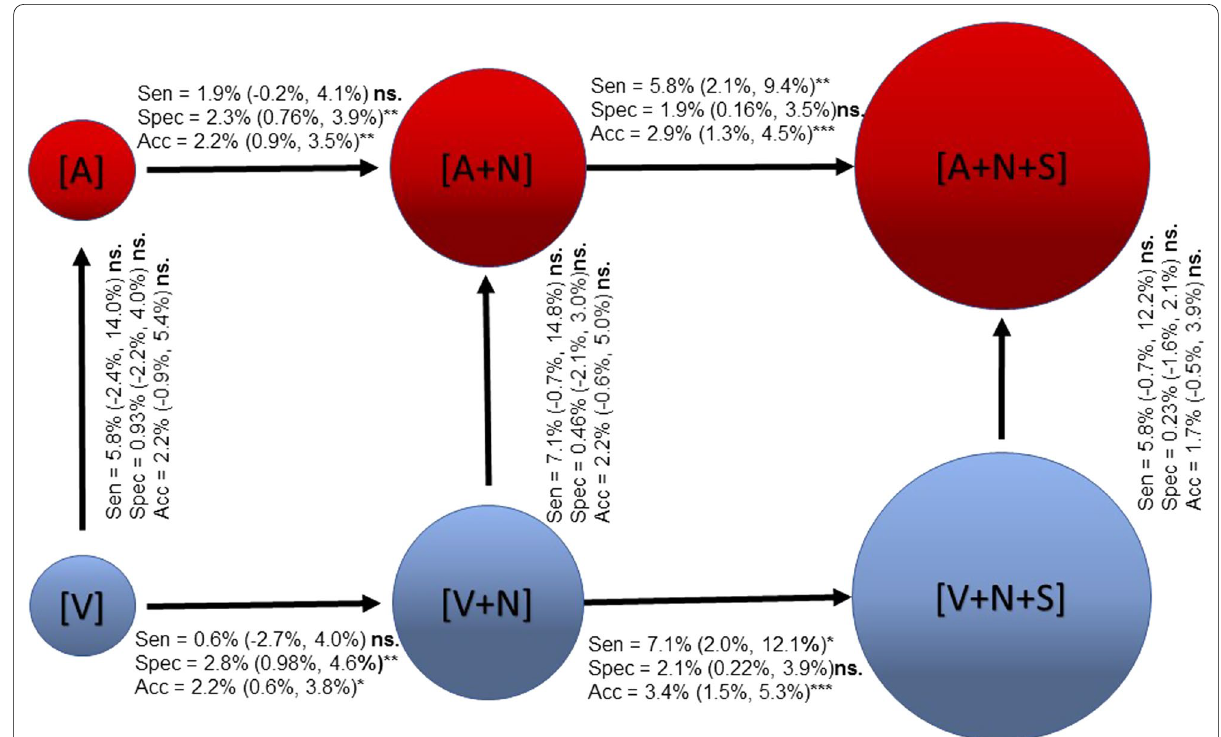
Fig. 4 Absolute difference in diagnostic sensitivity, specificity and overall accuracy when adding image sets (horizontal direction of the arrows) and when comparing the venous‑ and the arterial‑based image sets (vertical direction of the arrows). In parenthesis 95% confidence interval. ns non‑significant; (*) p 0.05; (**) p 0.01; (***) p 0.0001 = ≤ ≤ ≤